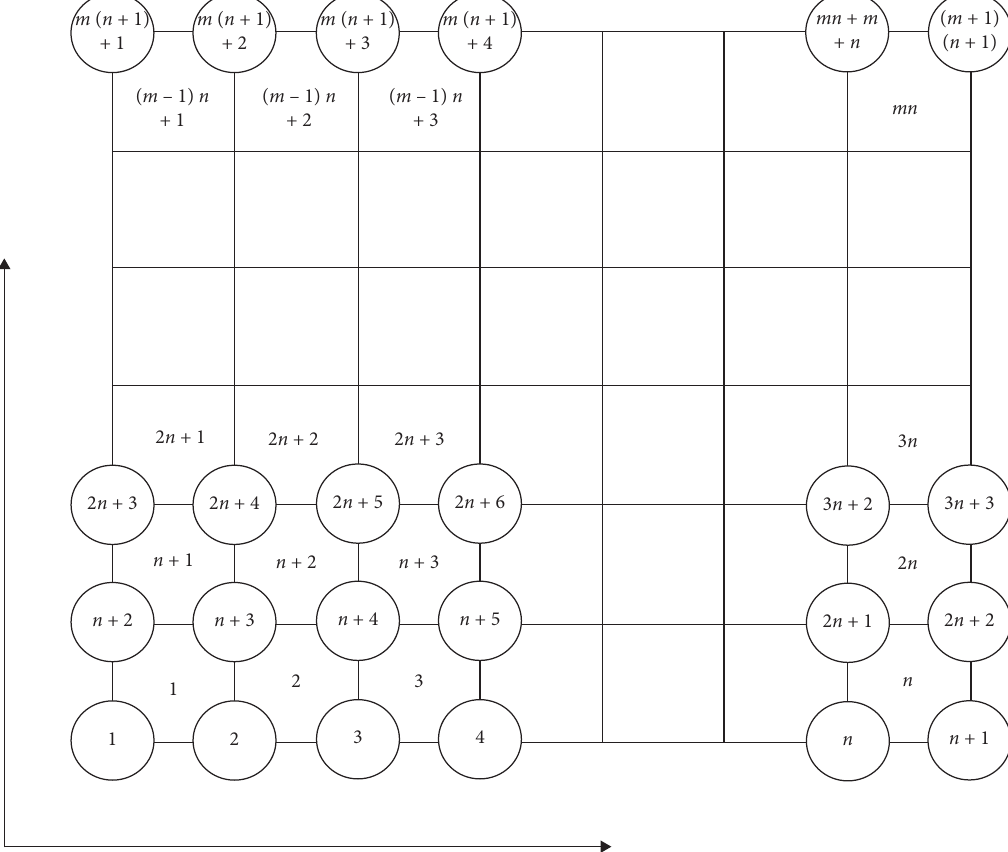
Figure 4: Sketch map of elements and nodes label for the image pixel matrix.